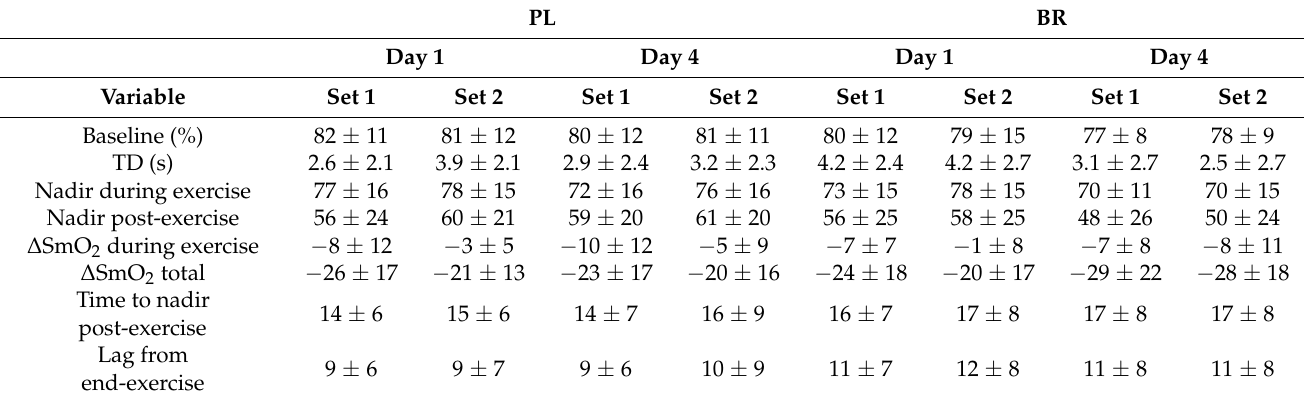
Table 4. Muscle oxygenation of the pectoralis major during a bench press exercise protocol for determination of power and velocity following acute and multiday nitrate supplementation.